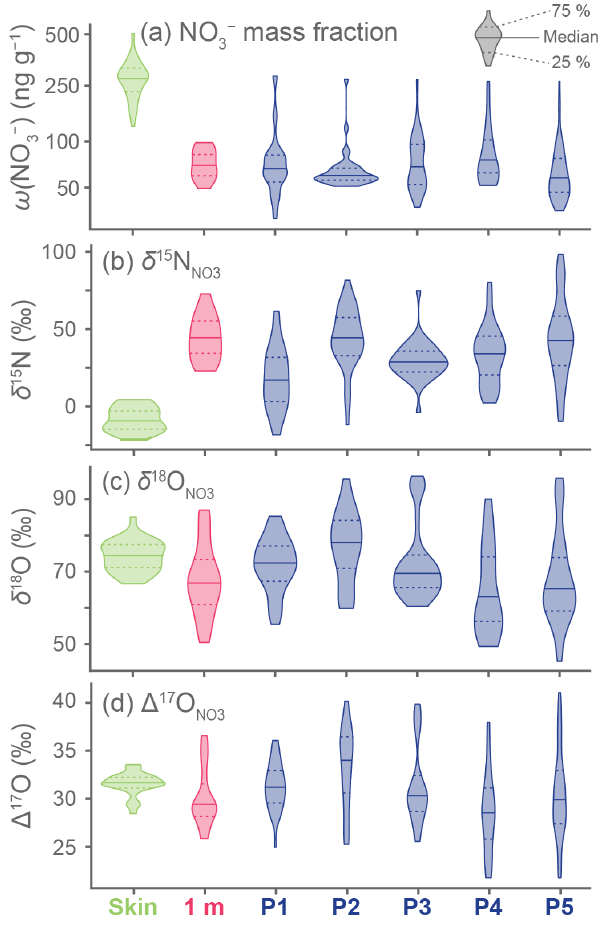
− analyt- Figure 3. Violin plots showing the distributions of NO 3 ical results. Samples in each subplot are grouped and colored by sampling method: skin layer (green), 1m depth layer (pink), or pits P1–P5 (blue). Data are plotted so that the total area of distribution is equivalent between groups, regardless of sample count. The median value per group is shown by a solid horizontal line, while the 25th and 75th percentiles are shown by dashed horizontal lines. Note that the y axis for ω (NO − ) (a) is log-transformed to better display the 3 much higher NO − concentrations in the skin layer samples relative 3 to other sample